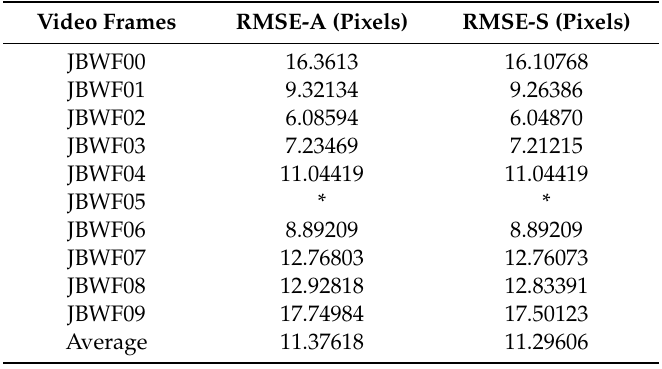
Table 3. Experimental results on dataset JBWF. Quantitative comparisons on di ff erent matching strategies using the